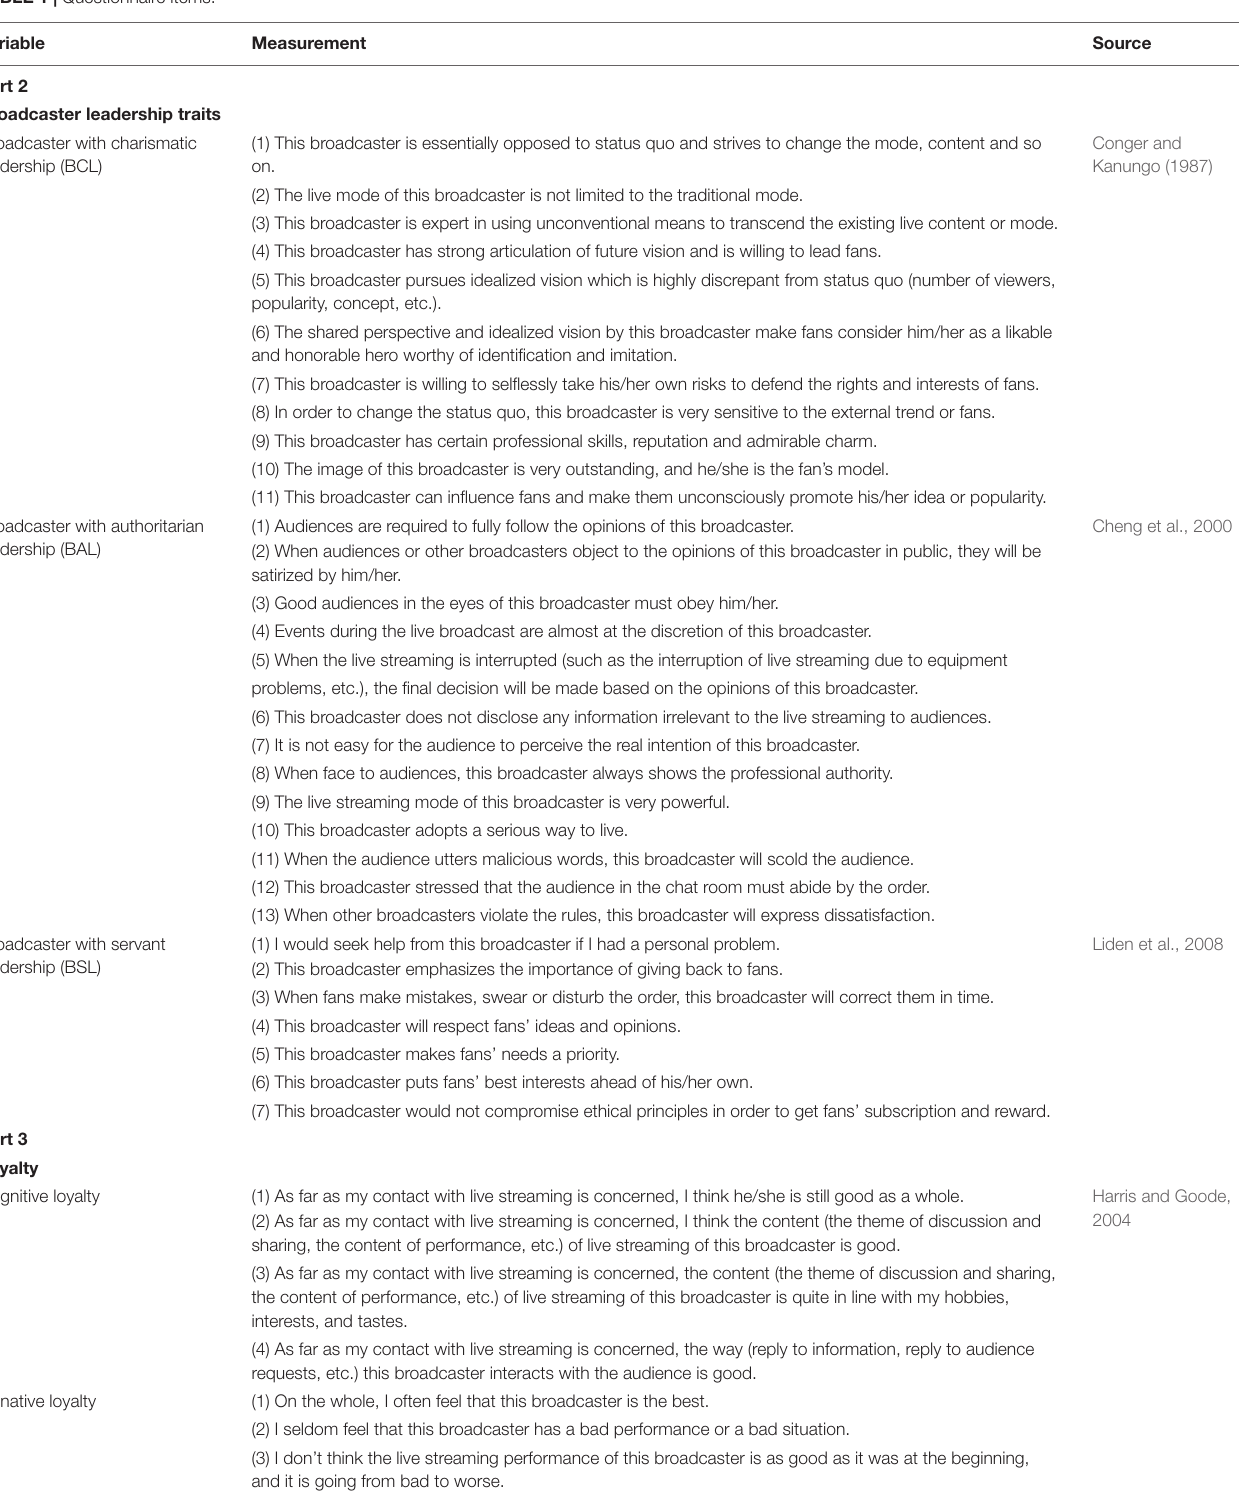
TABLE 1 | Questionnaire items. Variable Measurement Source Part 2 Broadcaster leadership